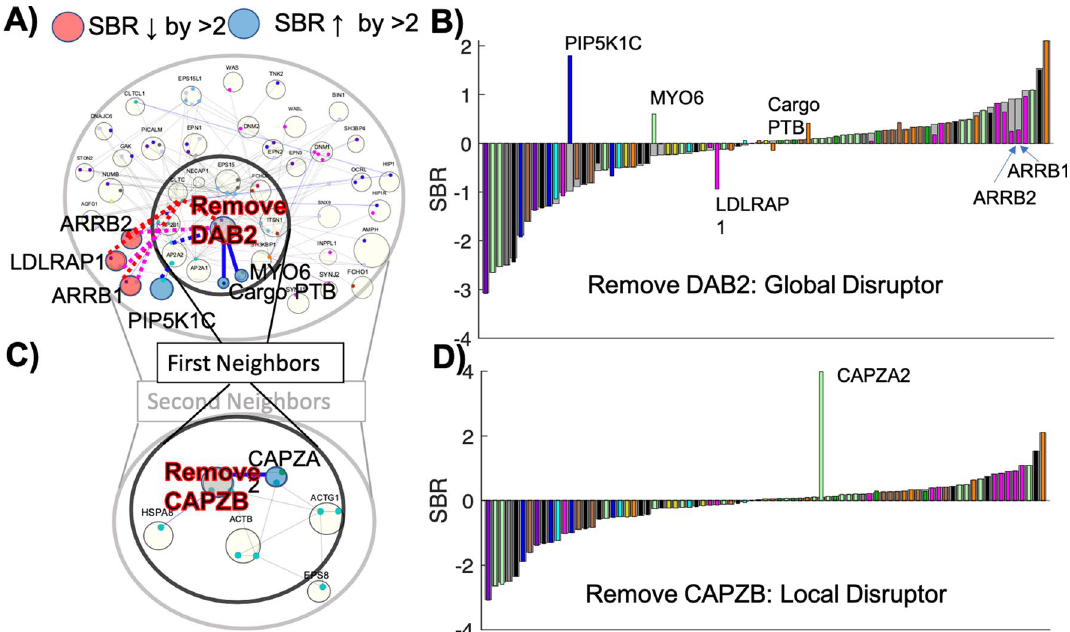
Figure 7. Removal of individual proteins from the network reveals their role as local or global controls of stoichiometry. ( A ) Removal of the multi-interface and highly connected DAB2 results in changes to stoichiometry to not only direct neighbors, but second neighbors (via interfaces) that compete with DAB2 to bind the same interfaces on AP2B1 and CLTC (red and pink dashed lines). ( B ) SBR of the HeLa network is shown ordered in gray, with the response following DAB2 removal in color bars. Proteins whose SBR changes by more than 2 are labeled in both ( A ) and ( B ). ( C ) Removal of CAPZB impacts stoichiometry of only its nearest neighbor CAPZA2. Partners of its immediate binding interfaces are shown. ( D ) SBR is essentially unchanged following CAPZB removal except for